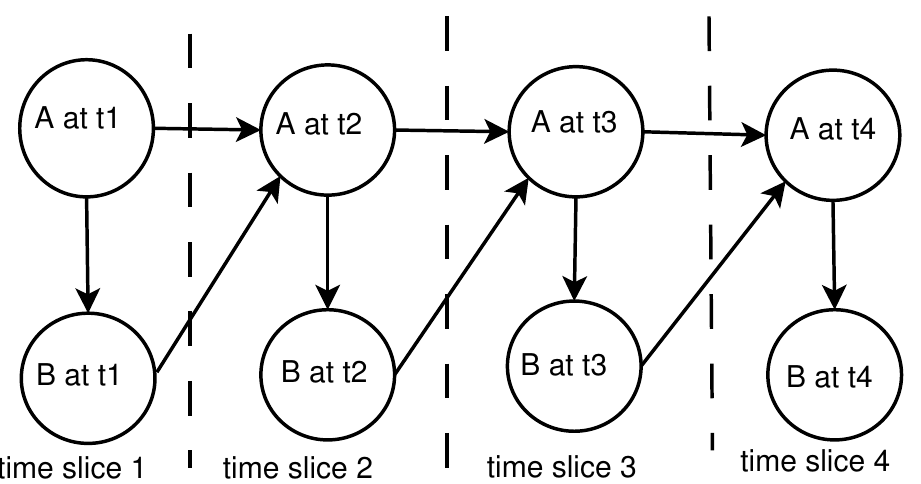
Figure 2. Dynamic Bayesian network representing a feedback